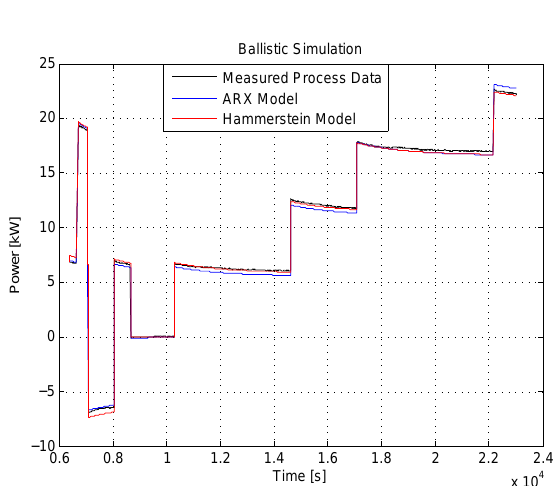
Figure 12: Ballistic simulation of the Hammerstein model of (21) after estimating d 1 and d 2 . The parameters b 1 , b 2 , and f 1 are identical to the ARX model identified in Section 6. The model is compared to measured process data and the ARX model.